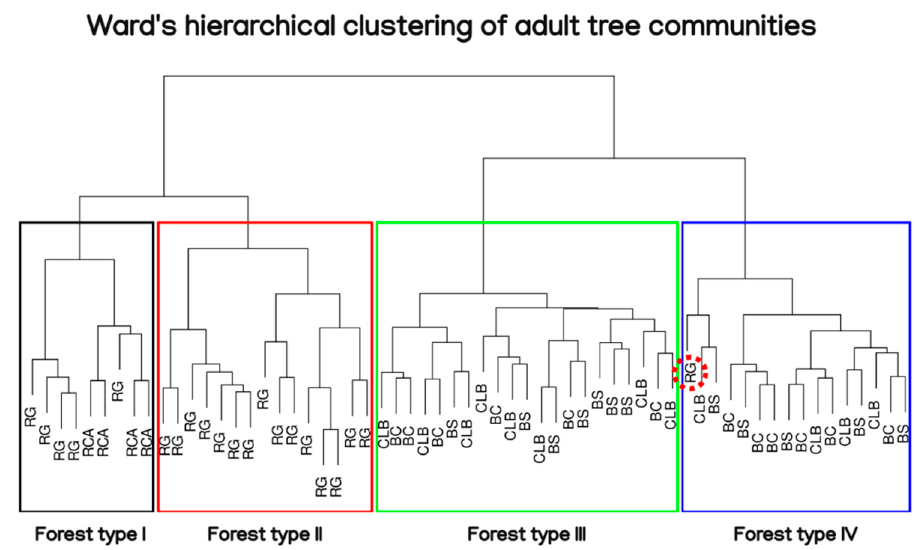
Figure 4. Hierarchical clustering of all sites using species community composition. Tips of the tree represent sites. These four obvious groupings were used to categorize the current ecological state of the forest at each site, or “Forest type”. Site circled with a red-dotted line represents site 10.1, which was historically pastured but regenerated to resemble an “old” forest type IV. The history of land use at each site is noted.